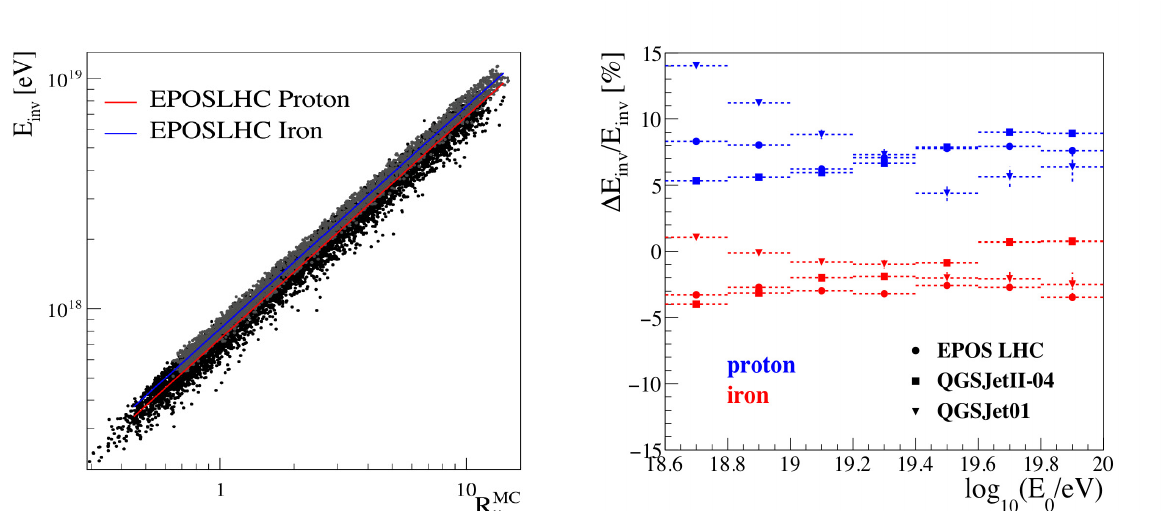
Figure 3. Left: Correlation between E inv and R MC for the proton (black dots) and iron (grey dots) showers simulated with EPOS LHC. µ Right: Average value of the relative di ff erence between the true value of E inv and the value E inv reconstructed using the EPOS LHC parameterisation for a mixture of 50% protons and 50% iron.